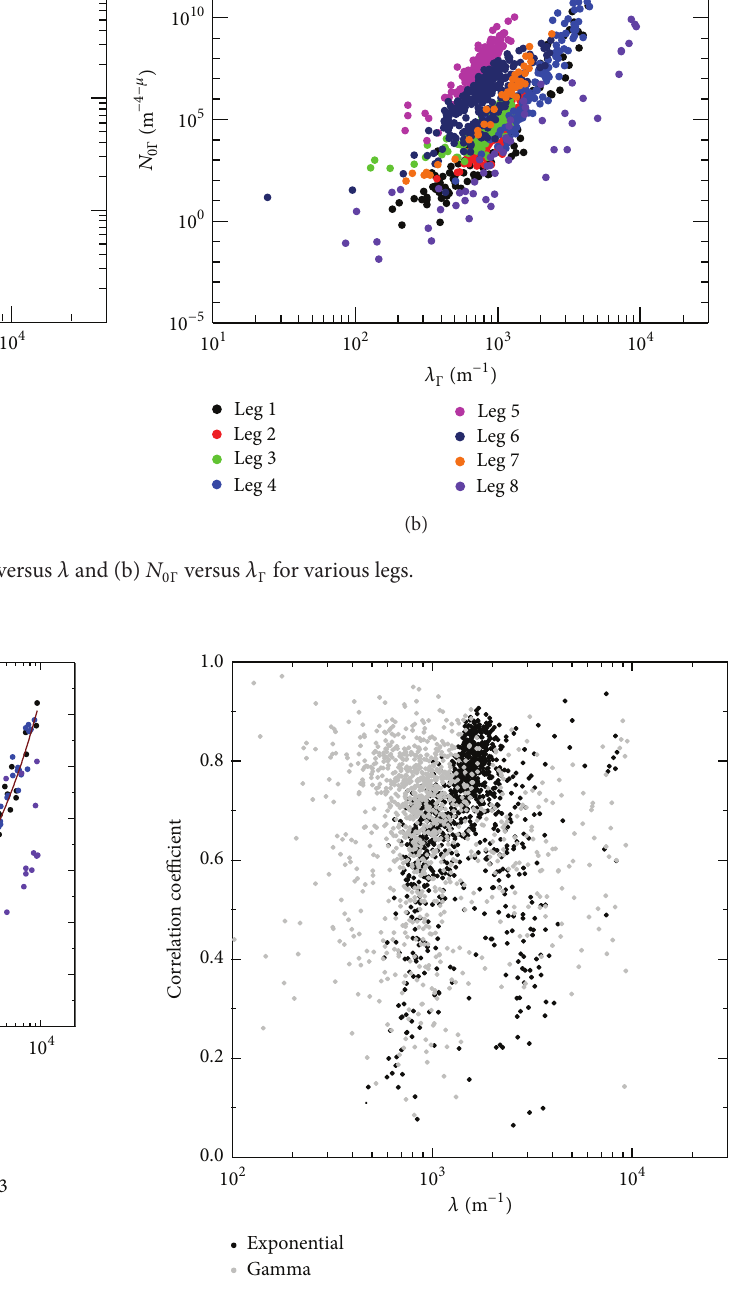
Figure 12: Correlation coefficients for exponential and gamma